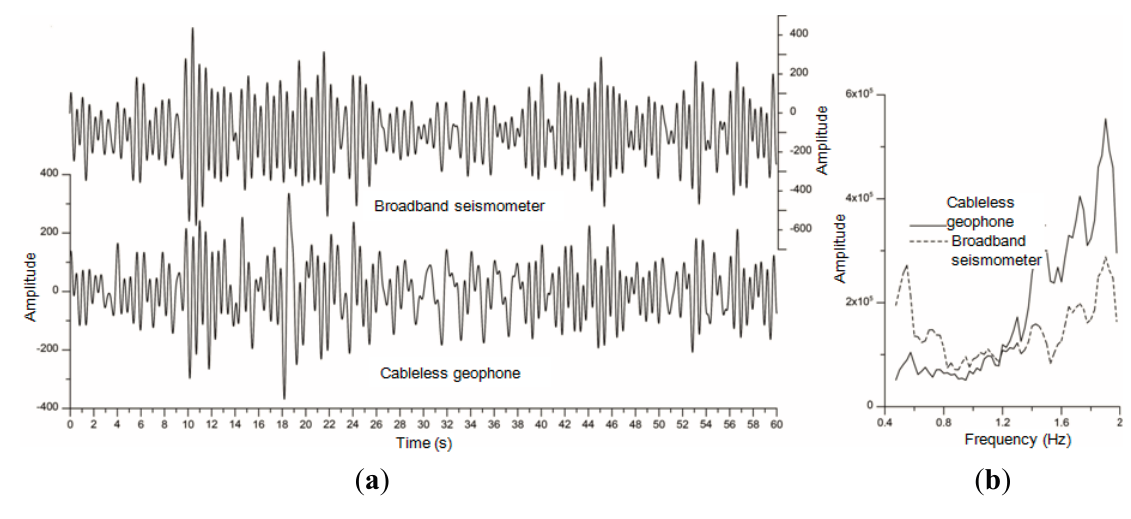
Figure 4. Comparison between the seismometer measurements and the cableless geophone